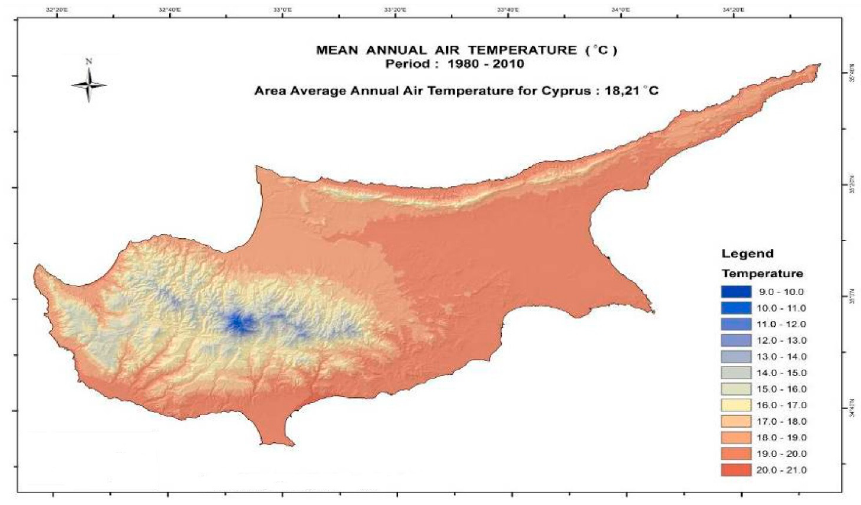
Figure 2. Mean annual temperature (°C) (source: AGWATER project).